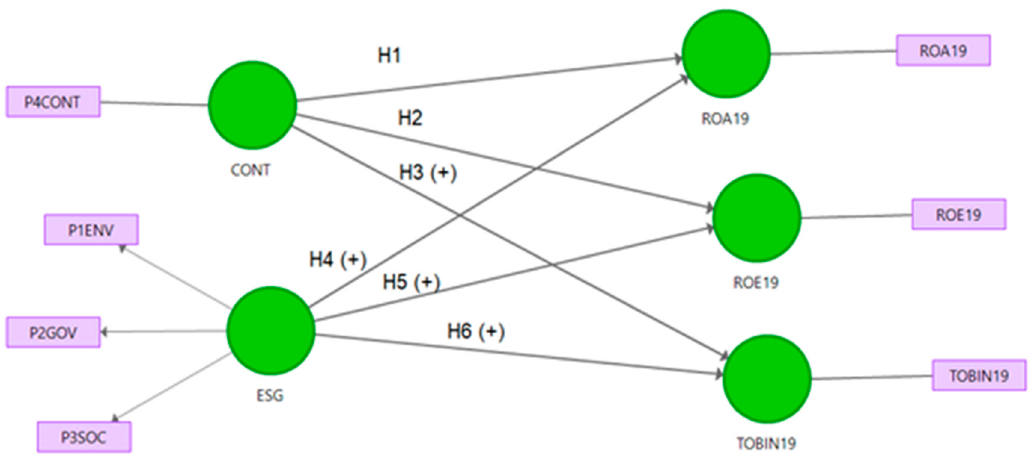
Figure 1. The theoretical research model.